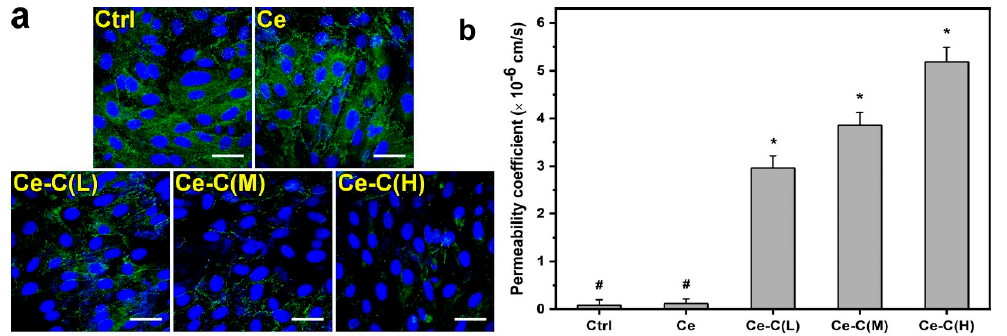
Figure 8. In vitro corneal permeability characteristics. ( a ) CLSM images of SIRC cell layers immunofluorescently stained with DAPI (blue fluorescence) and ZO-1 (green fluorescence) after incuba-